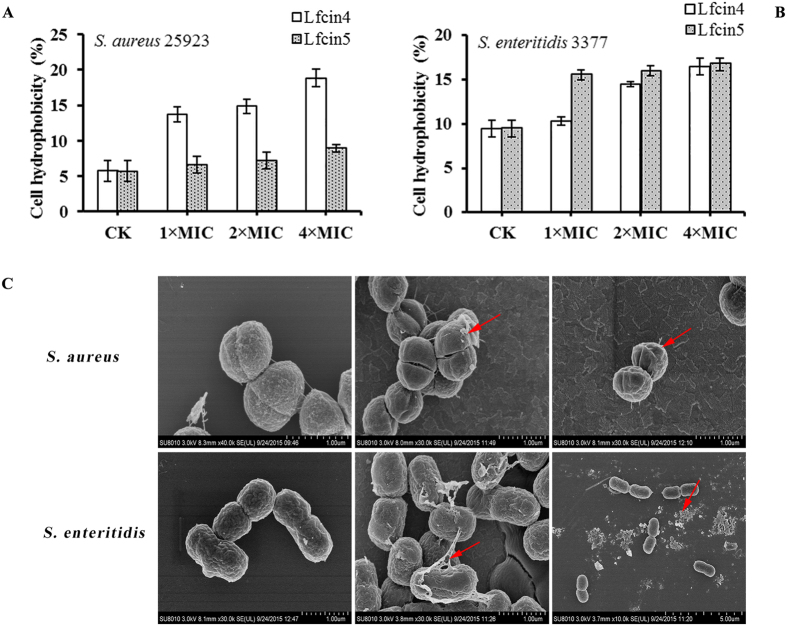
Effects of Lfcin4 and Lfcin5 on the cell surface hydrophobicity and cell morphology of bacteria.(A,B) Effects of Lfcin4 and Lfcin5 on the cell surface hydrophobicity of S. aureus ATCC25923 (A) and S. enteritidis CVCC3377. (B) The results are presented as the mean ± SEM (n = 3). (C) SEM photographs of S. aureus ATCC25923 and S. enteritidis CVCC3377 cells with or without 1 × MIC Lfcin4 and Lfcin5.